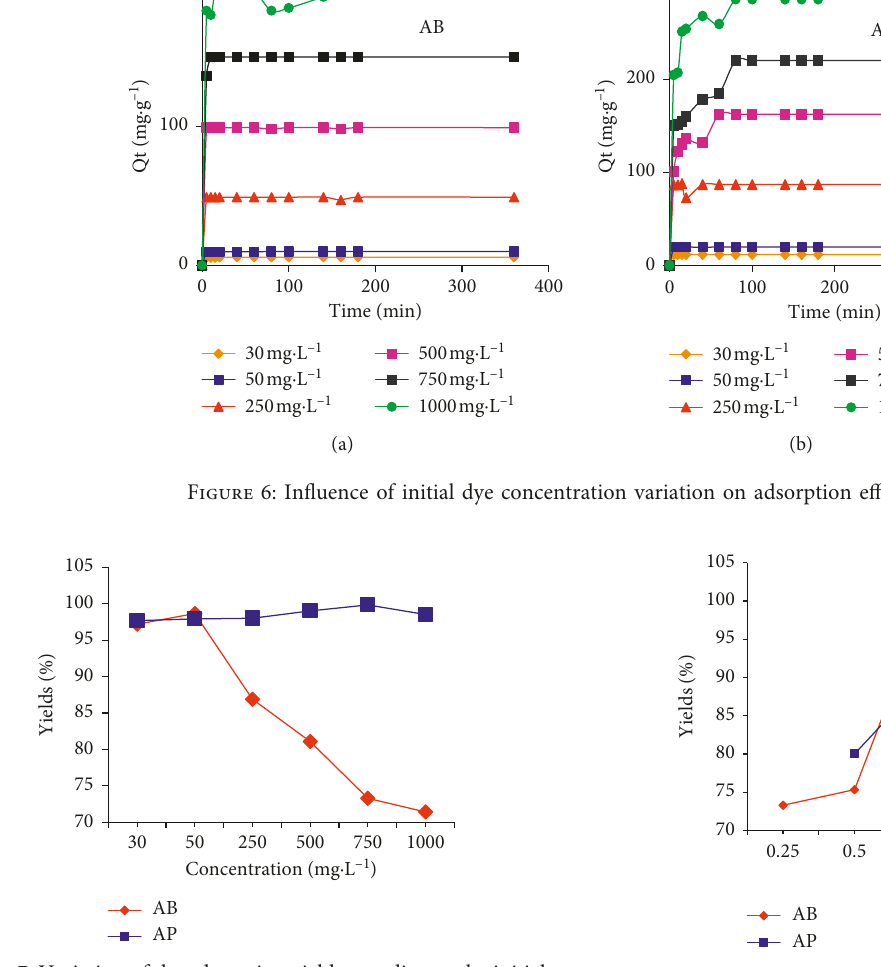
Figure 9: Influence of the variation of the mass of crude and purified Sejnane clay on the adsorption efficiency of methyl